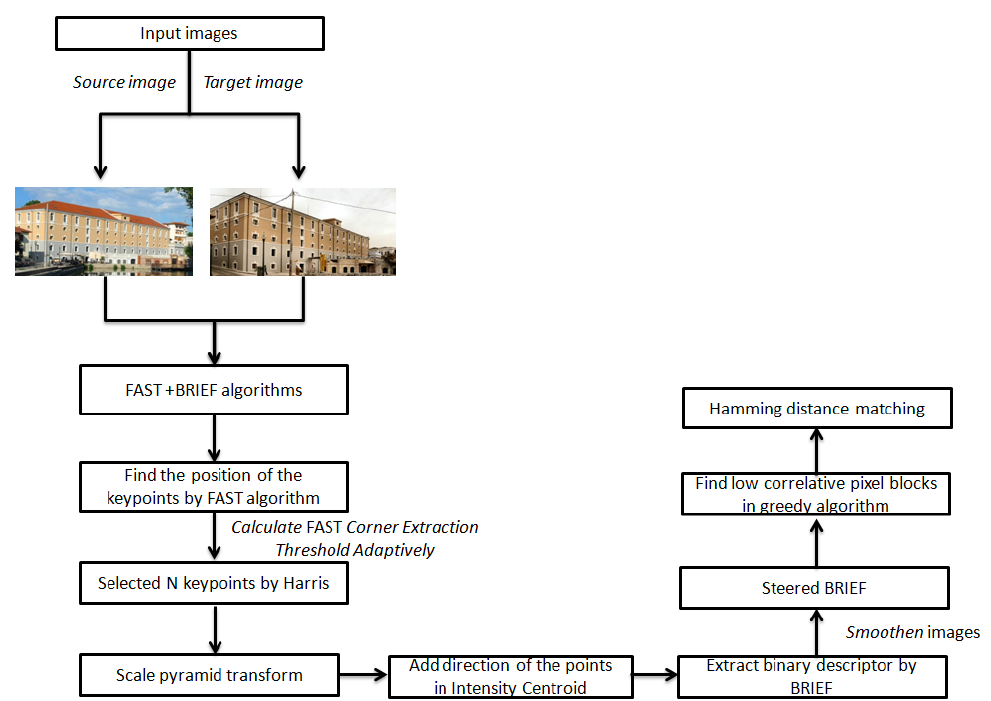
Figure 10. Workflow chart of ORB. The ORB detector takes the intensity threshold between the center pixel and those in a circular ring about the center, and FAST uses a simple measure of corner orientation, the intensity centroid that assumes that a corner’s intensity is offset from its center, and this vector is used to refer to an orientation.